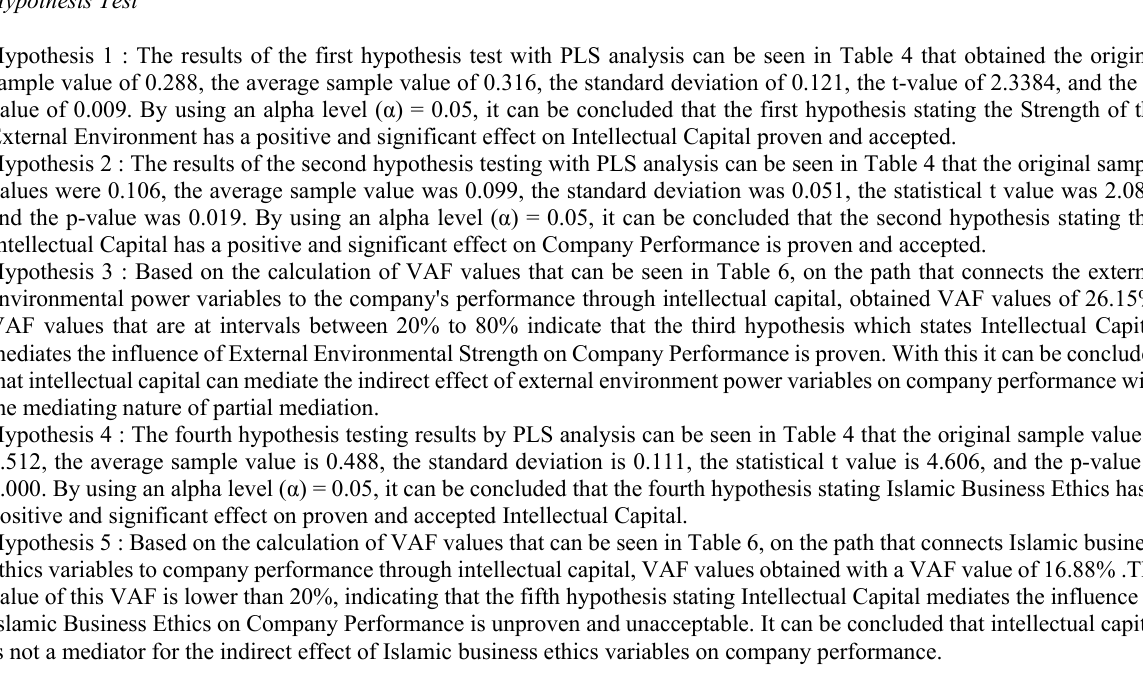
Results for calculating VAF values Pathway a b c VAF Nature of Mediation SEE  IC  CP 0.678 Hypothesis